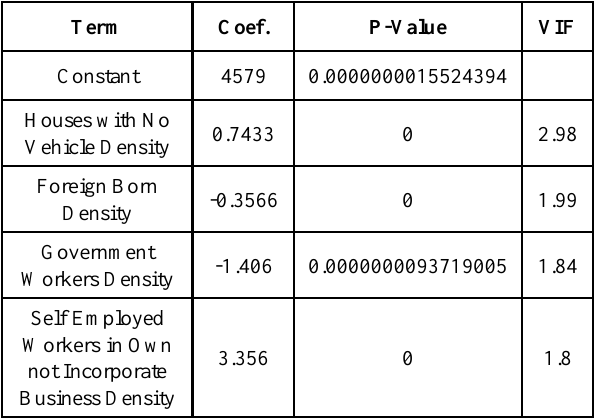
Table 3. Regression Results of Pick-up Location Driving Forces for Trips with Destinations other than Airports Achieving